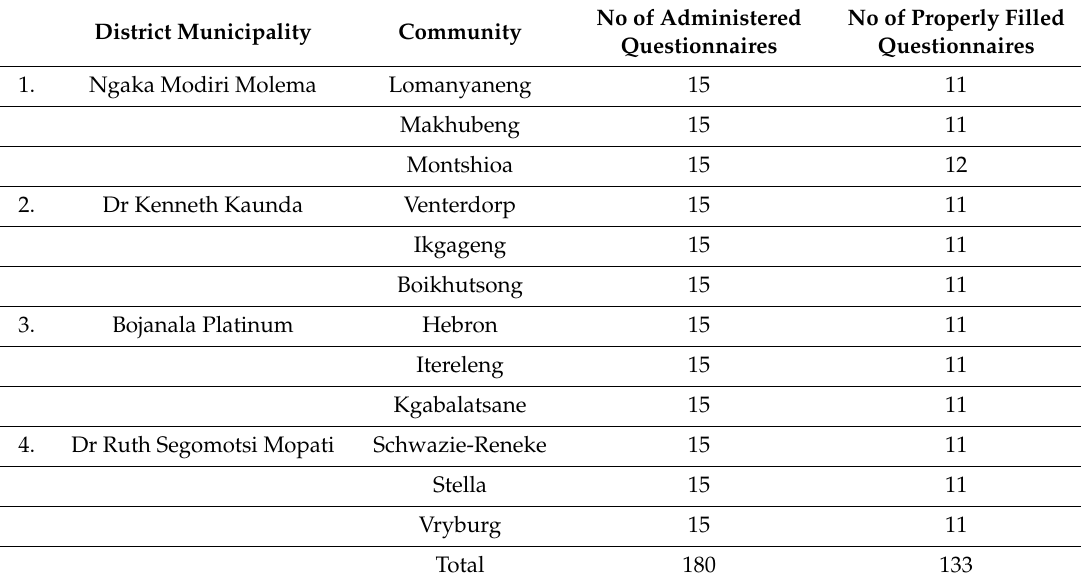
Bojanala Platinum